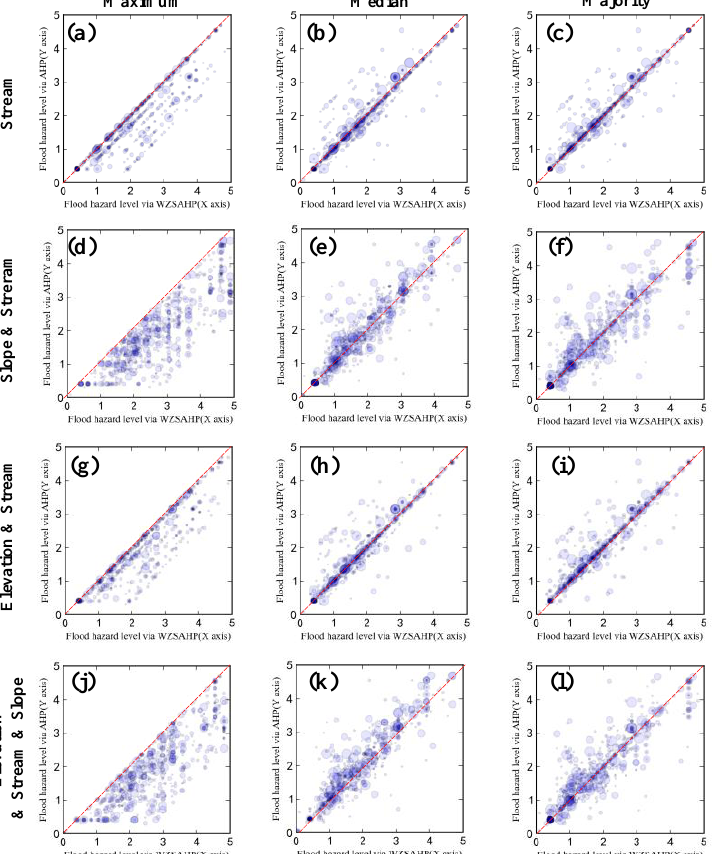
Figure 9. Scatter diagrams of flood hazard index derived by WZSAHP-RC via MFD delimitated sub-watershed as X-axis and flood hazard index derived by AHP as Y-axis. The converged indicator in ( a – c ), ( d – f ), ( g – i ), and ( j – l ) were the same, and the sub-figures in the same column used the same type of zonal statistical method.